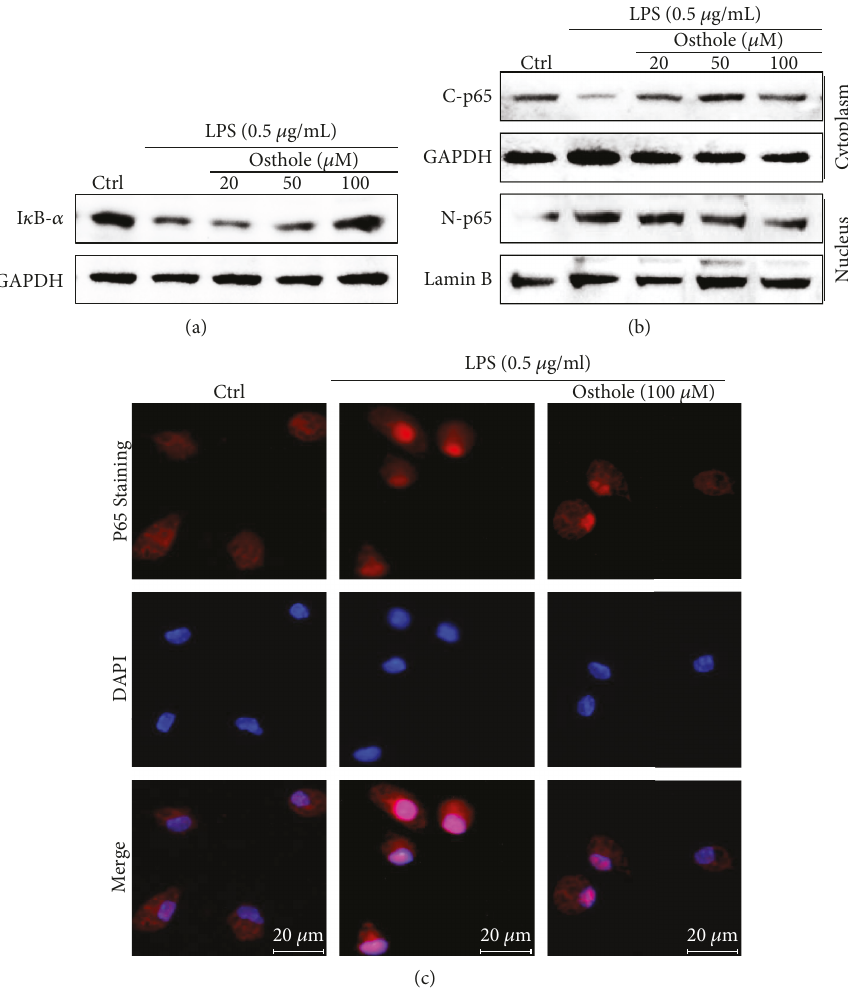
Figure 2: Osthole inhibits nuclear translocation of NF- κ B. The e ff ects of osthole on LPS-activated NF- κ B were determined from MPMs pretreated with the indicated concentrations of osthole for 1 h and stimulated with LPS (0.5 μ g/mL) for 0.5h (a – b) or 1 h (c). (a) Representative Western blot analysis of cell lysates for I κ B- α ; GAPDH as loading control; n = 3 . (b) Representative Western blot analysis of cytoplasmic and nuclear cell fractions for the p65 subunit of NF- κ B (C-P65 and N-P65, resp.); GAPDH and lamin B are respective loading controls; n = 3 . (c) For immuno fl uorescence evaluation of nuclear translocation of the p65 subunit, the osthole-pretreated MPMs were stimulated with LPS (0.5 μ g/mL) for 1h; p65 (red) and DAPI nuclear stain (blue), n = 3 , micron bar = 20 μ m